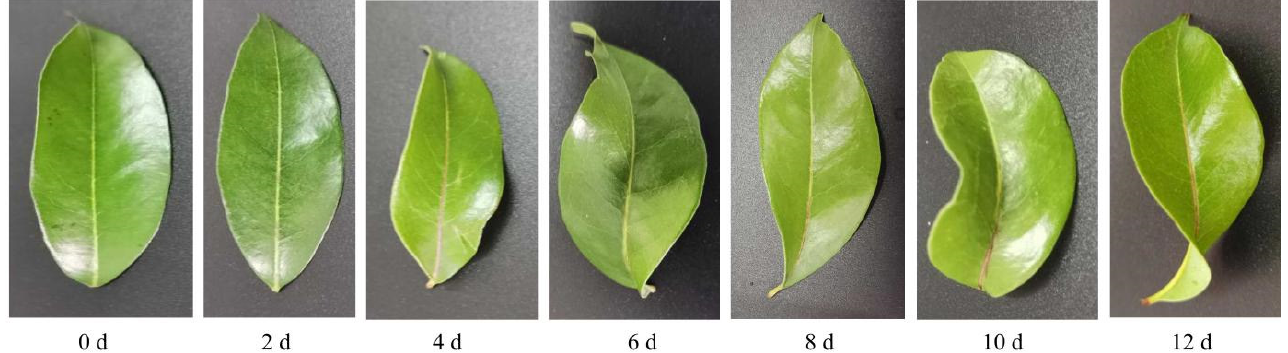
Figure 1. Leaf phenotype of ‘Huaizhi’ litchi trees under chilling stress. ‘Huaizhi’ litchi trees were transferred to a growth chamber. Temperature of the chambers dropped from 22 ◦ C/17 ◦ C (day/night temperature, 12 h day and 12 h night) to 2 ◦ C in 4 days, and then remained at 2 ◦ C for another 8 days. The days represent the samples of ‘Huaizhi’ litchi leaves on 0 d, 2 d, 4 d, 6 d, 8 d, 10 d, and 12 d under low-temperature conditions.